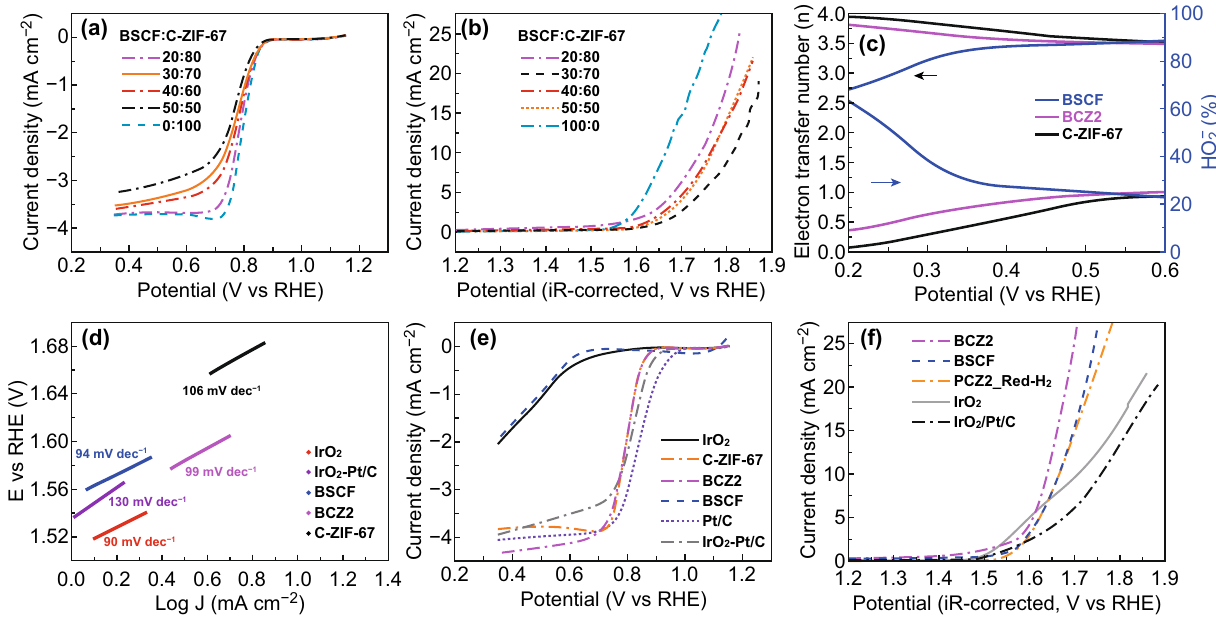
Fig. 3 a ORR and b OER polarization curves of composite samples prepared by physical mixing using different ratio in an oxygen‑saturated 0.1 M KOH at a rotating speed of 1600 rpm. c Electron transfer number and percentage of HO 2− of BSCF, C‑ZIF‑67 and BCZ2 composites at vari‑ ous potentials. d Tafel plots, e ORR and f OER polarization curves of various samples including BCZ2 composite in an oxygen‑saturated 0.1 M KOH at a rotating speed of 1600